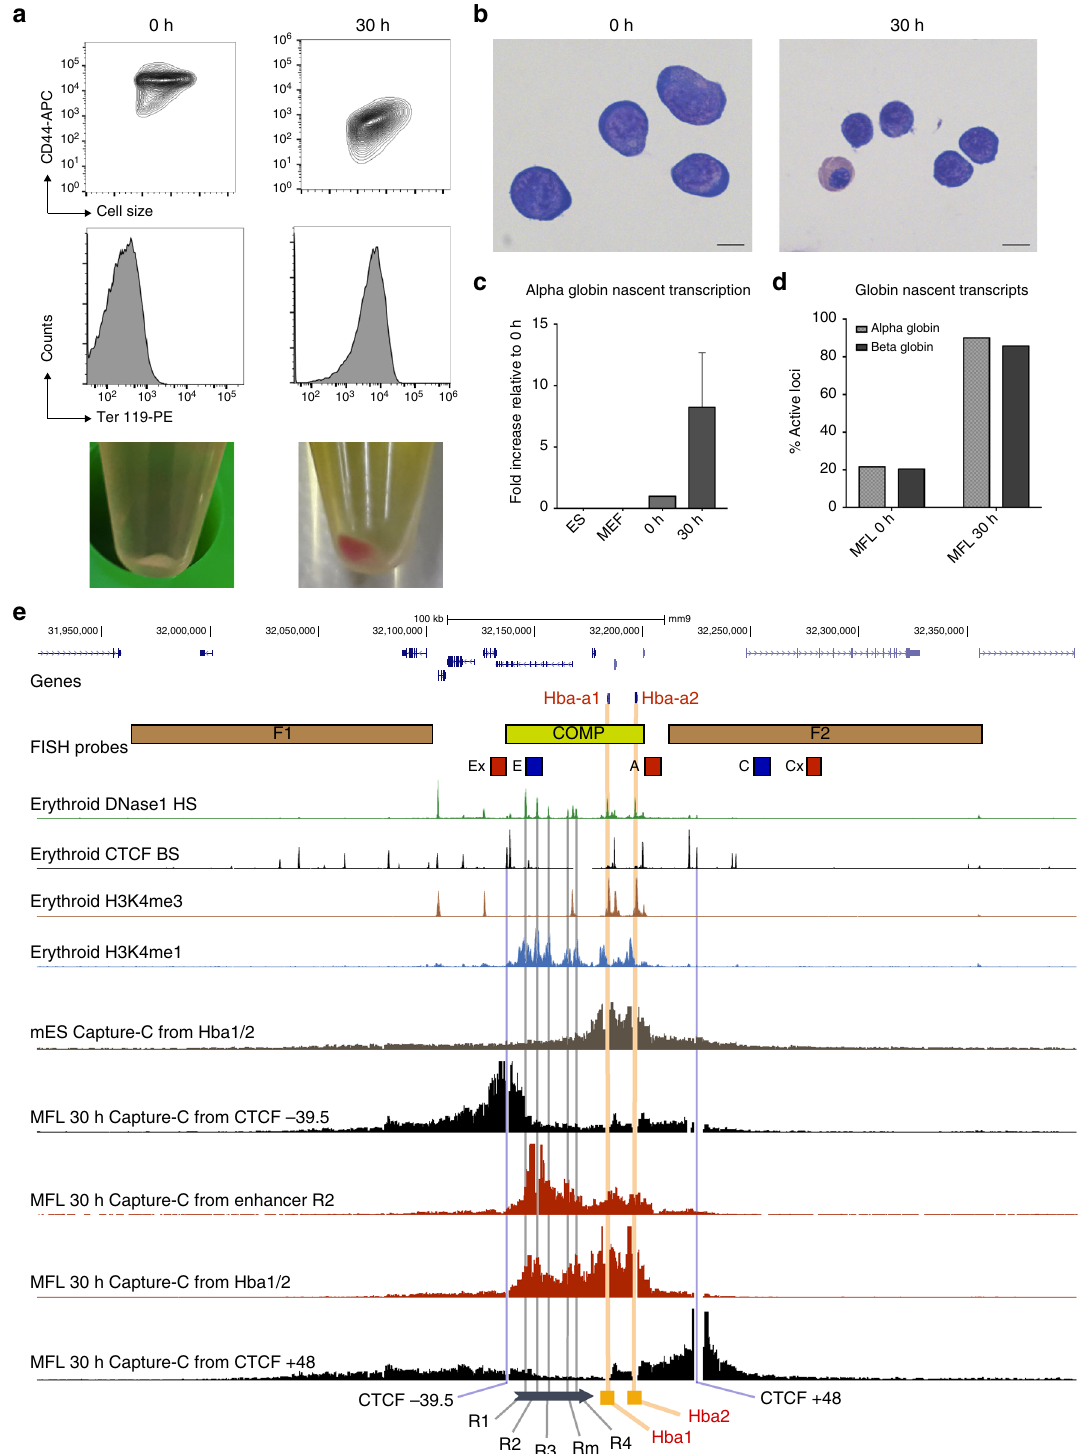
(Fig. 3a, b). We found no signi fi cant differences between COMP- F1 and COMP-F2 in mES cells, MFL 0 h or MFL 30 h erythro- blasts (Fig. 3c, Supplementary Fig. 3). However, we noted that although the linear genomic distance between F1 and F2 is twice that of COMP-F1 or COMP-F2, the median inter-probe distances between F1 and F2 are nevertheless shorter at MFL 0 h (Fig. 3c). Importantly at MFL 30 h, we observed a further, highly signi fi cant shortening of F1 – F2 measurements compared to COMP-F1 and